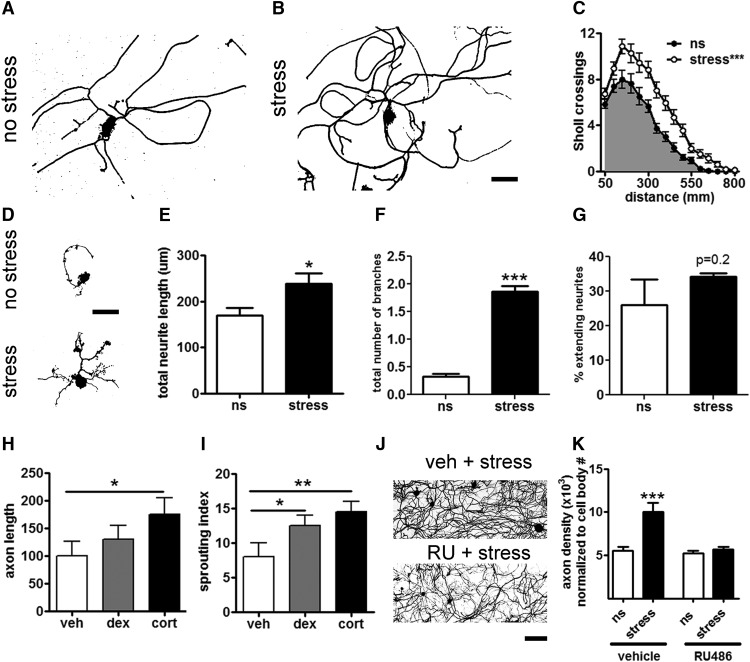
Acute stress promotes neurite growth via a GC-GR-dependent mechanism. A, B, DRG neurons were isolated from ns or stressed mice and grown in vitro for 72 h. Scale bar, 100 µm. C, Stress increased neurite length. ***p < 0.0001 versus ns, one-way ANOVA. D-F, Stress increases neurite growth during the “arborizing” phase of DRG neurite outgrowth. D, DRG neurons from Thy1-GFP-M transgenic mice were isolated from ns adult mice or adult mice subjected to 1 h of restraint stress and grown for 15 h in vitro. Scale bar, 100 µm. E, F, Stress increased neurite total length and the number of branches per neurite, *p < 0.05, ***p < 0.0001, mean and SEM are shown. G, The percentage of neurons extending neurites was unaffected by stress. All parameters were defined by the Neuronal Profiling Algorithm v4.1 (Cellomics ArrayScanXTI, Thermo Fisher). N ≥ 550 neurons per condition. H, I, Cort administration (1.5 mg/kg) 1 h before DRG harvest increased neurite elongation and sprouting measures 24 h after plating in vitro. I, The synthetic GC, dex (2 mg/kg) increased neurite sprouting, *p < 0.05, **p < 0.01. J, Representative images of high-density DRG neuron cultures (72 h in vitro) from vehicle-treated and RU486-treated (RU) stressed mice. Scale bar, 200 µm. K, The GR antagonist, RU486 blocked stress enhanced neurite growth, ***p < 0.0001 versus ns, mean ± SEM are shown.